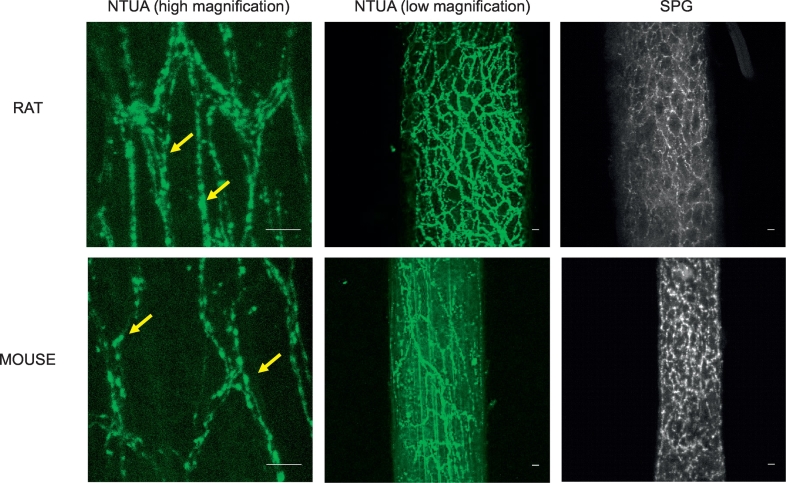
NTUA and SPG labelling of noradrenergic nerves in the rodent mesenteric arteries. At high magnifications, NTUA incubation (left panels; yellow arrows) labelled noradrenergic nerves at the level of single terminals. At low magnifications, NTUA (middle panels) and SPG (right panels) incubation demonstrated perivascular noradrenergic nerves arranged in thick bundles that wraps around the entirety of the vessel.For all micrographs, bars = 10 μm.